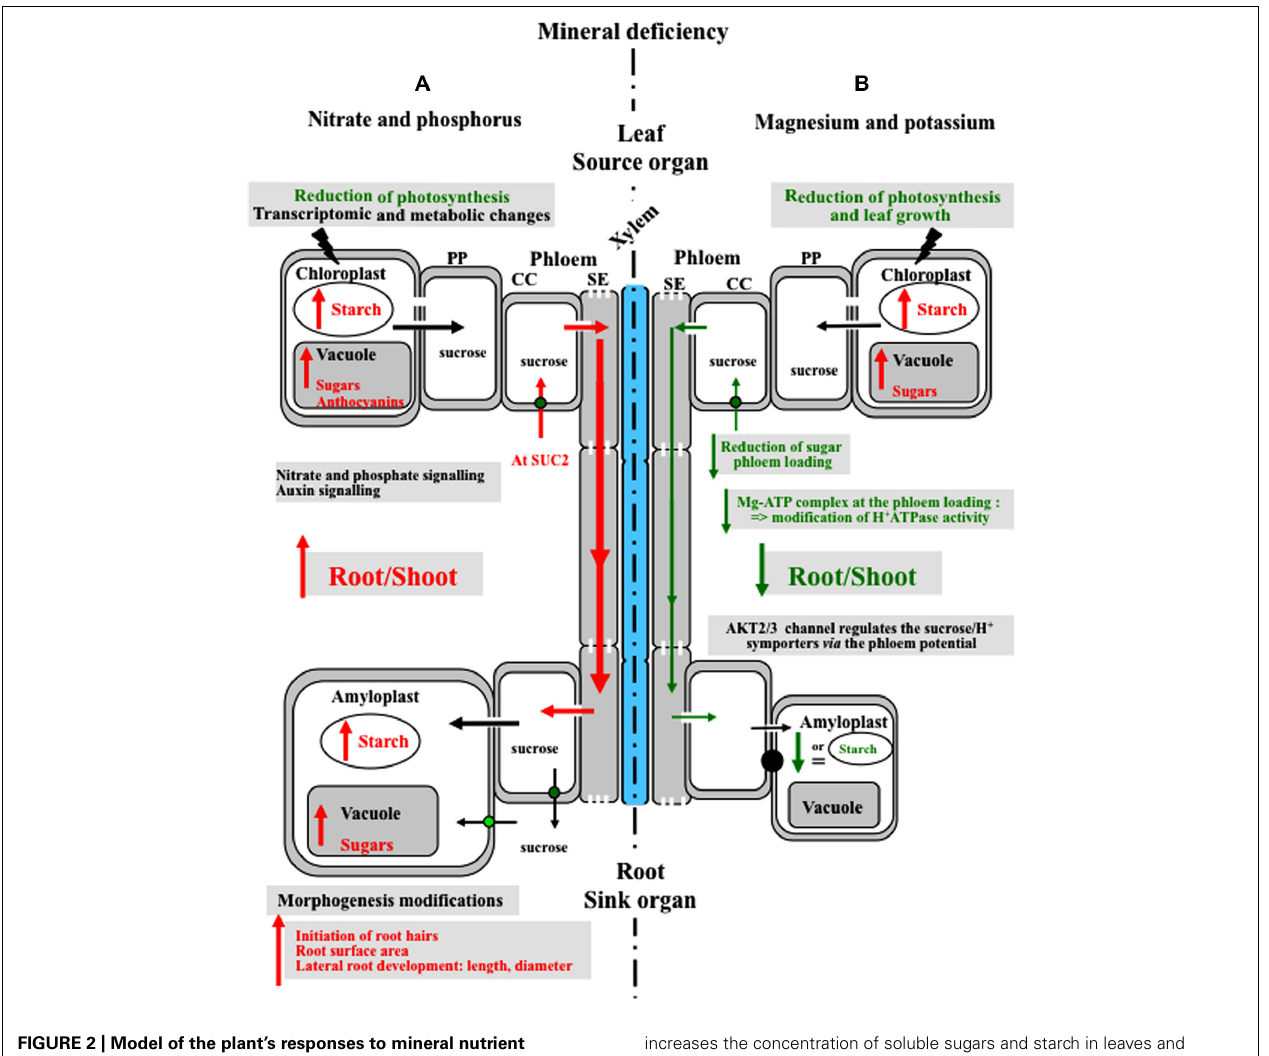
FIGURE 2 | Model of the plant’s responses to mineral nutrient deficiency. (A) Response to nitrate and phosphorus deficiency: deficiency in nitrogen and phosphorus leads to reduced photosynthesis, accumulation of sugars in source leaves, increased carbon allocation to the roots and a higher root/shoot ratio. Moreover, phosphorus limitation induces an adaptation of the root system architecture: root hairs initiate and elongate, which increases the root surface area. AtSUC2 (green circle) is a component of the sugar-signaling pathway in the response to phosphorus starvation. (B) Response to magnesium and potassium deficiency: Mg deficiency